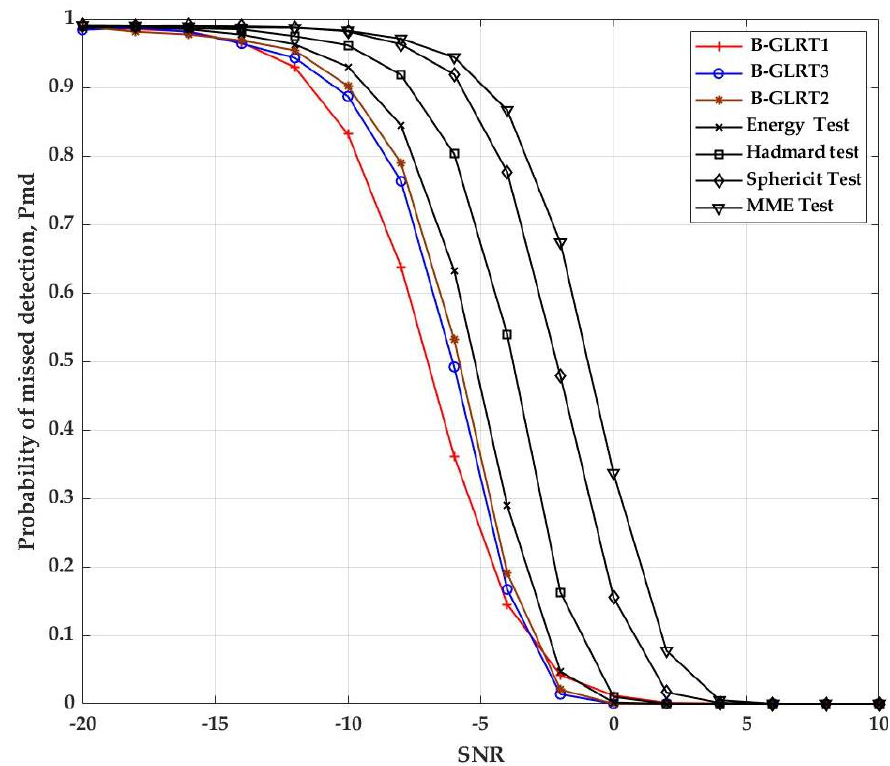
Figure 3. Probability of missed detection versus the SNR for Pf a = 5 × 10 − 1 , N r = 3 and L =